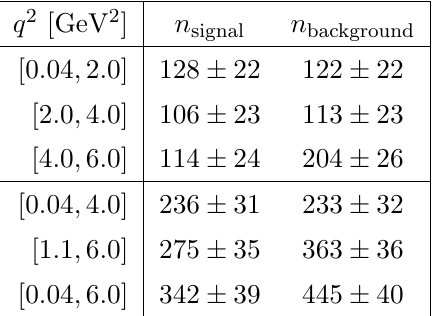
, and background, n , yields obtained for signal background